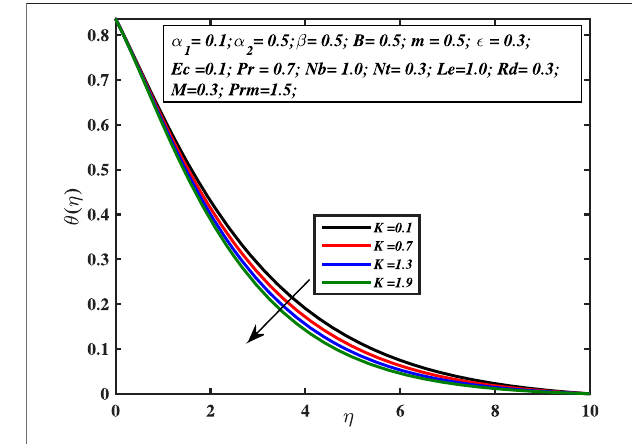
FIGURE 4 | Effect of β on the velocity curve.